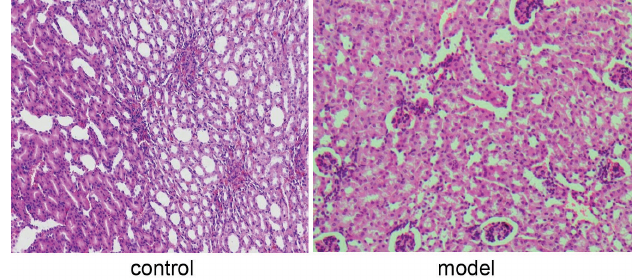
FIGURE 6 - Pathological section of renal tissue in 4 th week (HE×200).